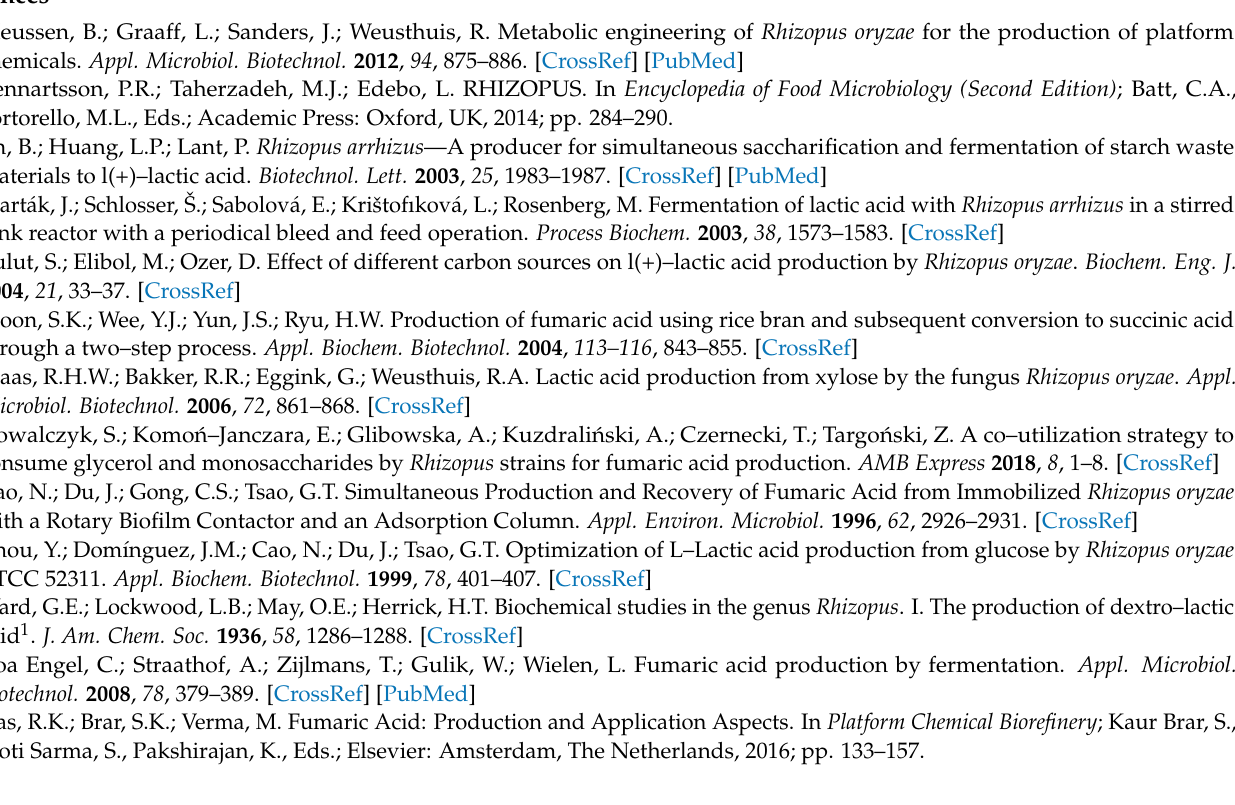
samples; Figure S5: metabolite symptoms in almond shoots after 24 and 72 h: (a) fumaric acid, (b) lactic acid, (c) ethanol, and (d) control (water). * R1—replicate 1, R2—replicate 2, R3—replicate